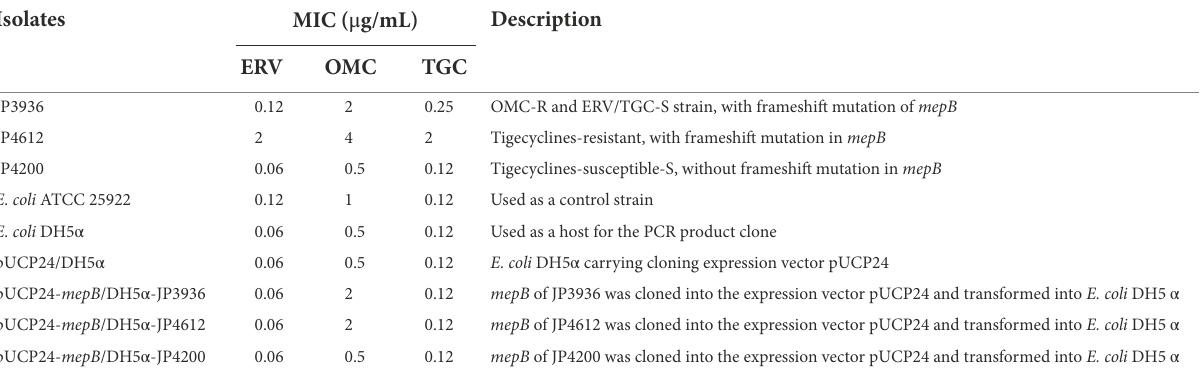
TABLE 5 Changes in the MIC of tetracyclines and the information of isolates used in the cloning experiments in this study.